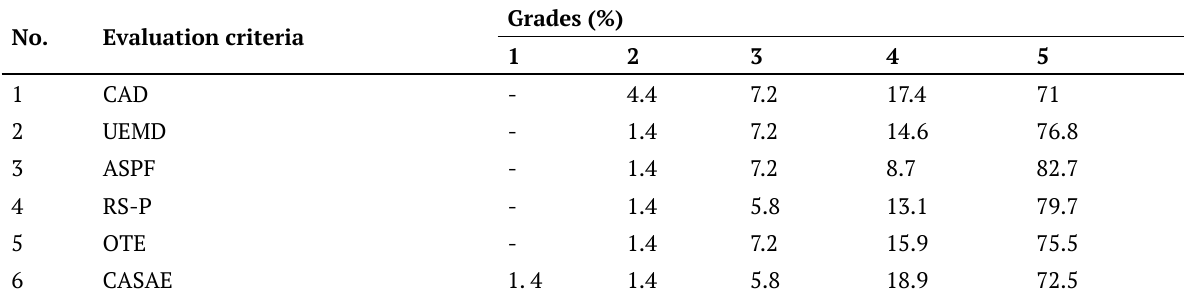
Table 3. Weight of students’ opinions regarding the didactic activity carried out at Kinesiology (n=46).